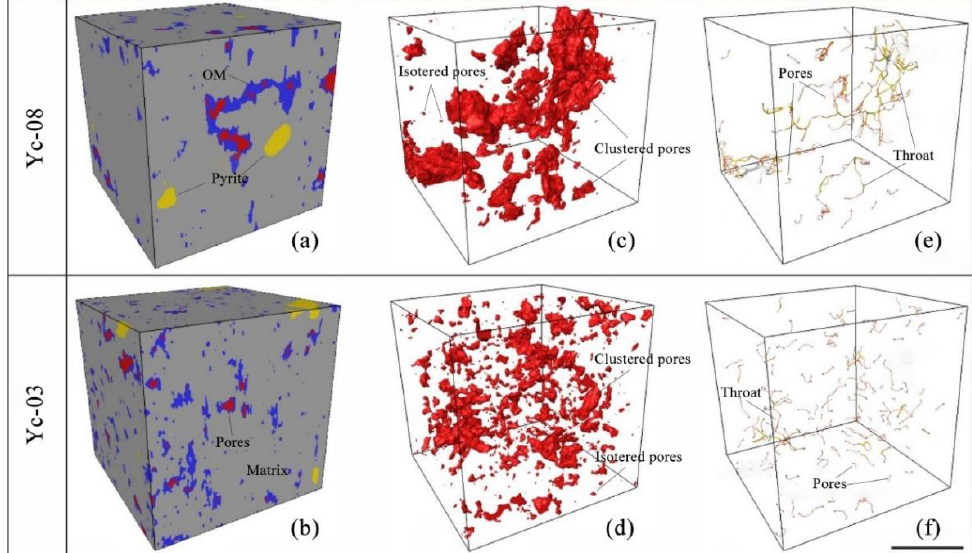
Figure 7. Models from X-ray analysis of samples Yc-08 and Yc-03 demonstrating ( a , b ) microstructures, ( c , d ) pores, and ( e , f ) pore connectivity characteristics under skeleton model. Organic matter is represented by OM, while the horizontal black line in the bottom right corner is set to a scale of 10 μm.